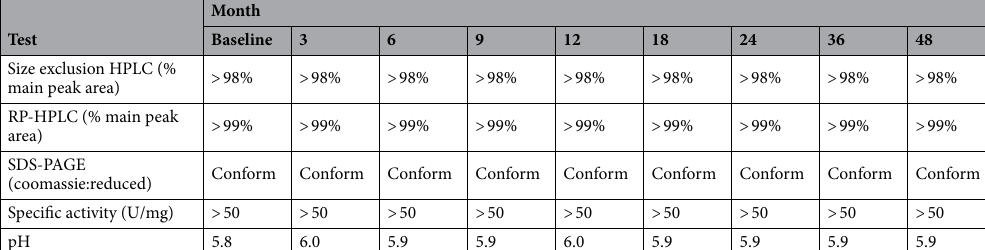
Table 1. Long-term stability data for one representative lot of the target sulfatase drug